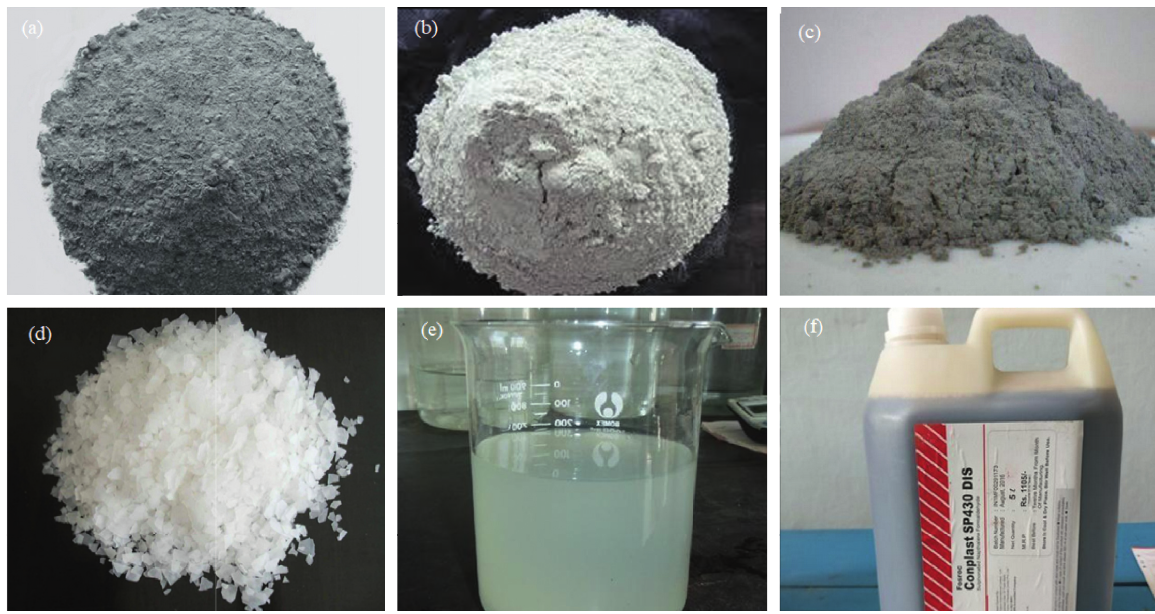
Figure 1: Raw constituents of the geopolymer mortar. (a) FA. (b) GGBFS. (c) Quarry dust. (d) NaOH flakes. (e) Sodium silicate solution. (f) Superplasticizer.